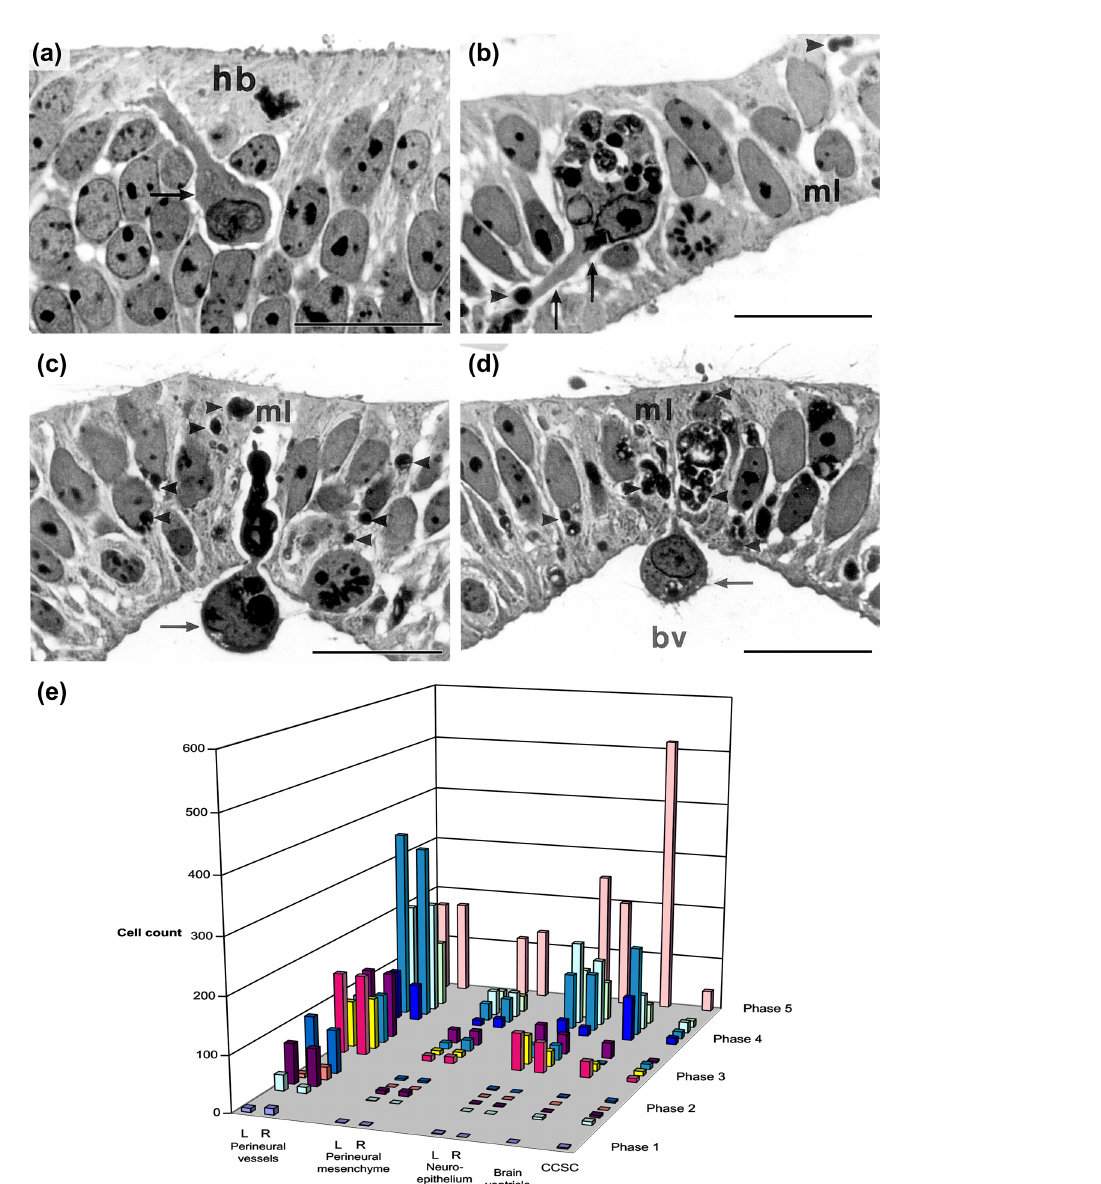
Figure 13. Earliest occurrence of macrophages in the developing brain of Tupaia belangeri . (a–d) Semithin sections stained with hema- toxylin (Heidenhain) from phase 3 ( a , “onset of invagination of the optic vesicle”) and phase 4 ( b–d , “advanced invagination of the optic vesicle”). (a) Lateral wall of the hindbrain (hb): migrating macrophages (arrow) are surrounded by a distinct halo. (b) Midline (ml) of the forebrain: an intramural macrophage is filled with phagosomes and extends pseudopods (arrows) to phagocytize apoptotic bodies (arrow- heads). (c, d) Intraventricular macrophages (arrows) in contact with the neuroepithelium. Arrowheads, apoptotic bodies; bv, brain ventricle. (e) Macrophages in perineural and neural compartments of Tupaia embryos which were classified according to five phases of ocular devel- opment. Except for the brain ventricle and the central canal of the spinal cord (CCSC), macrophages were separately counted for left and right sides of the brain. Scale bars = 20µm. Reproduced from Knabe and Kuhn (1999, Figs. 2a, 3e–f, 4a, b). © Springer-Verlag 1999, with kind permission from Springer Science and Business